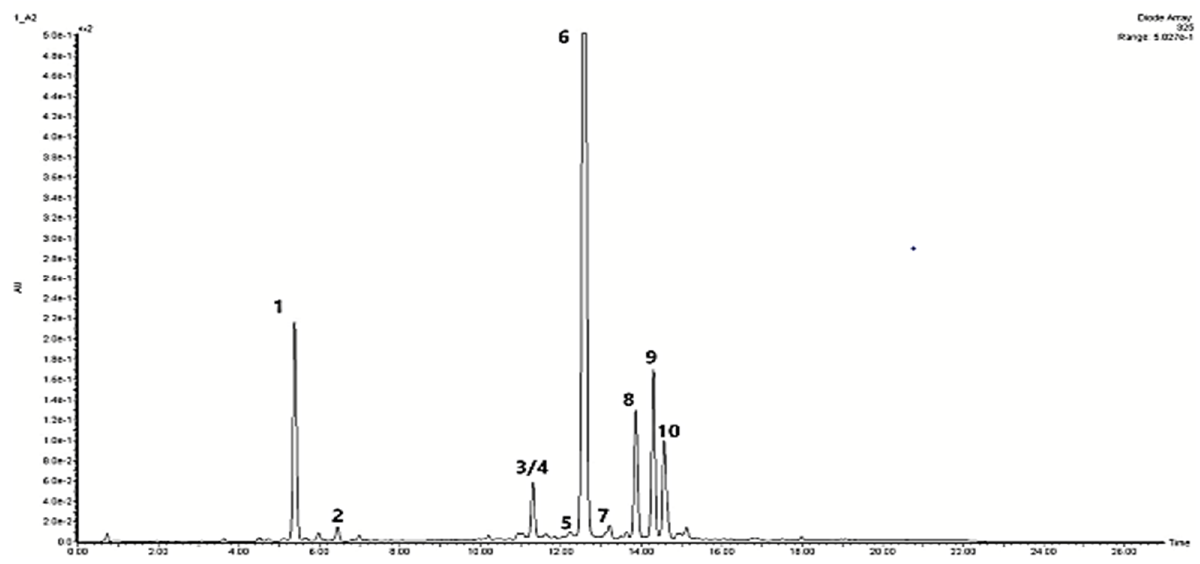
Figure 6. HPLC chromatogram of hydromethanolic extract from shoot culture of D. forrestii grown in blue light Peak numbers correspond to those in Table 1. The detection wavelength was set at 325 nm. (1) Chlorogenic acid, (2) Caffeic acid, (3/4) Salvianolic acid I/H and Salvianolic acid E, ( 5 ) Dicaffeoylquinic acid, (6) Rosmarinic acid, (7) Lithospermic acid, (8) Salvianolic acid B, (9) Apigenin p -coumarylrhamnoside, (10) Metyl rosmarinate.